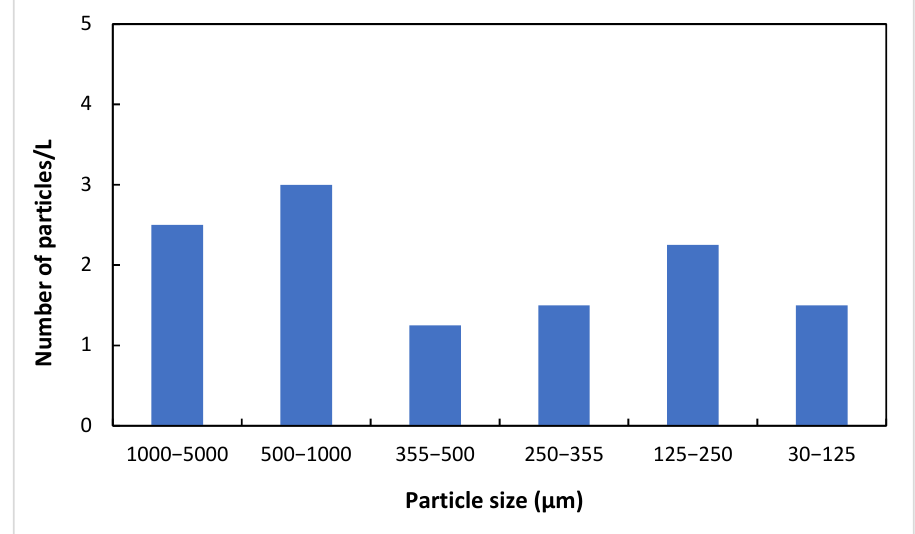
Figure 6. Size fractions in the sand-filter backwash water from sand-filtered wastewater .